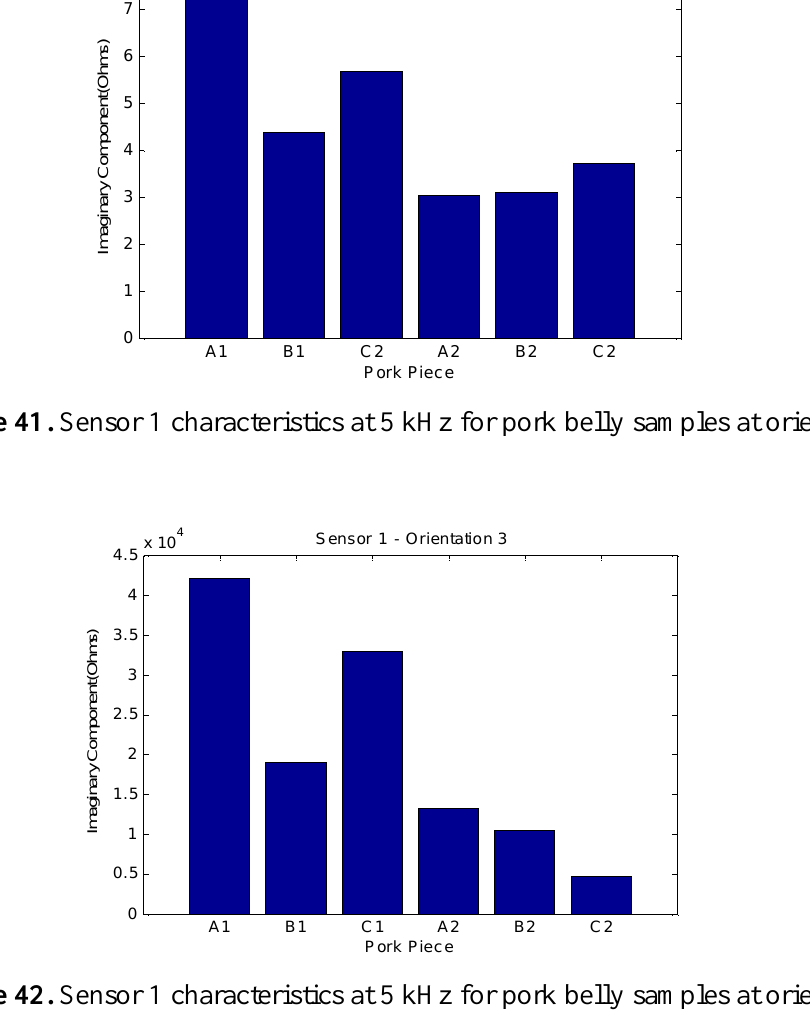
Figure 42. Sensor 1 characteristics at 5 kHz for pork belly samples at orientation